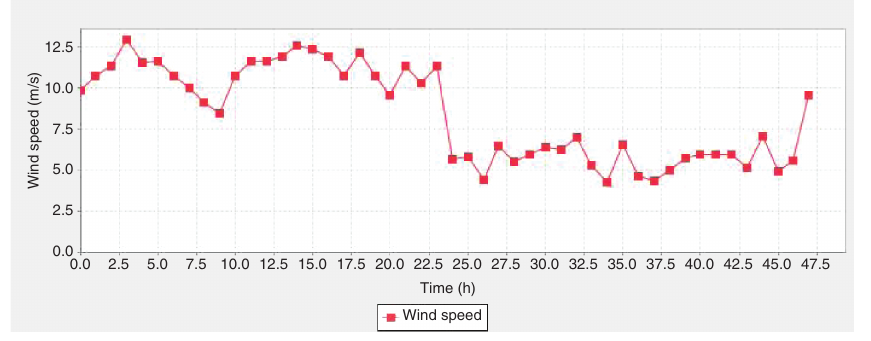
Figure 12: Profile of the Wind Speed.